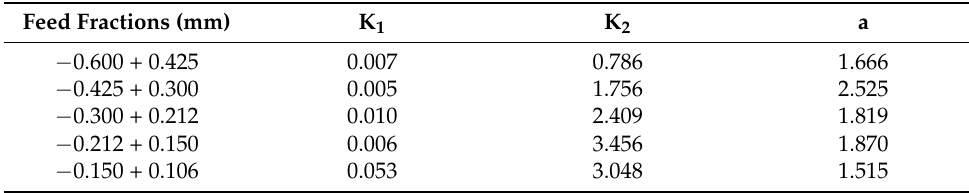
Table 6. Values of each parameter for different feed